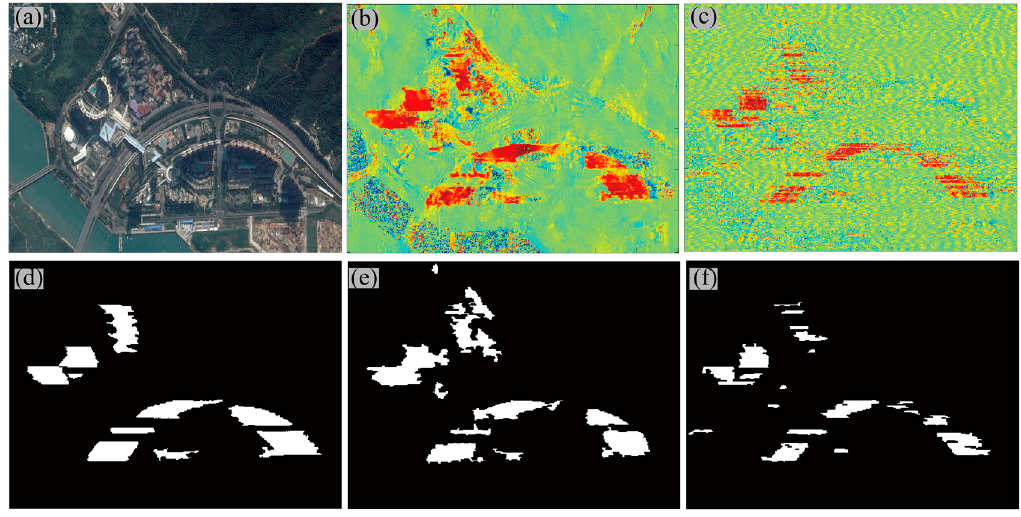
Figure 8. Building layover detection result of Tung Chung: ( a ) optical images; ( b ) frequency result in the range direction obtained by the proposed method; ( c ) result of the ramp detector; ( d ) artificial extracting result; ( e ) final result of the proposed method; and ( f ) final result of the ramp detector.